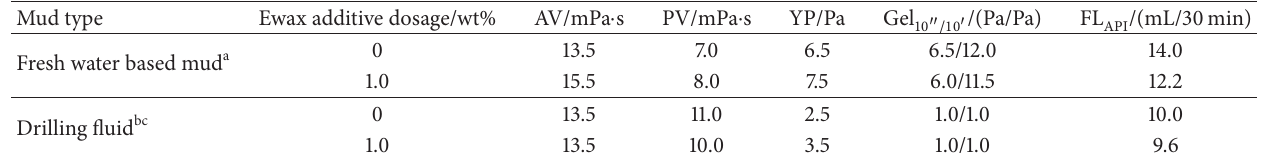
Table 3: Impact of Ewax on drilling fluid rheology.